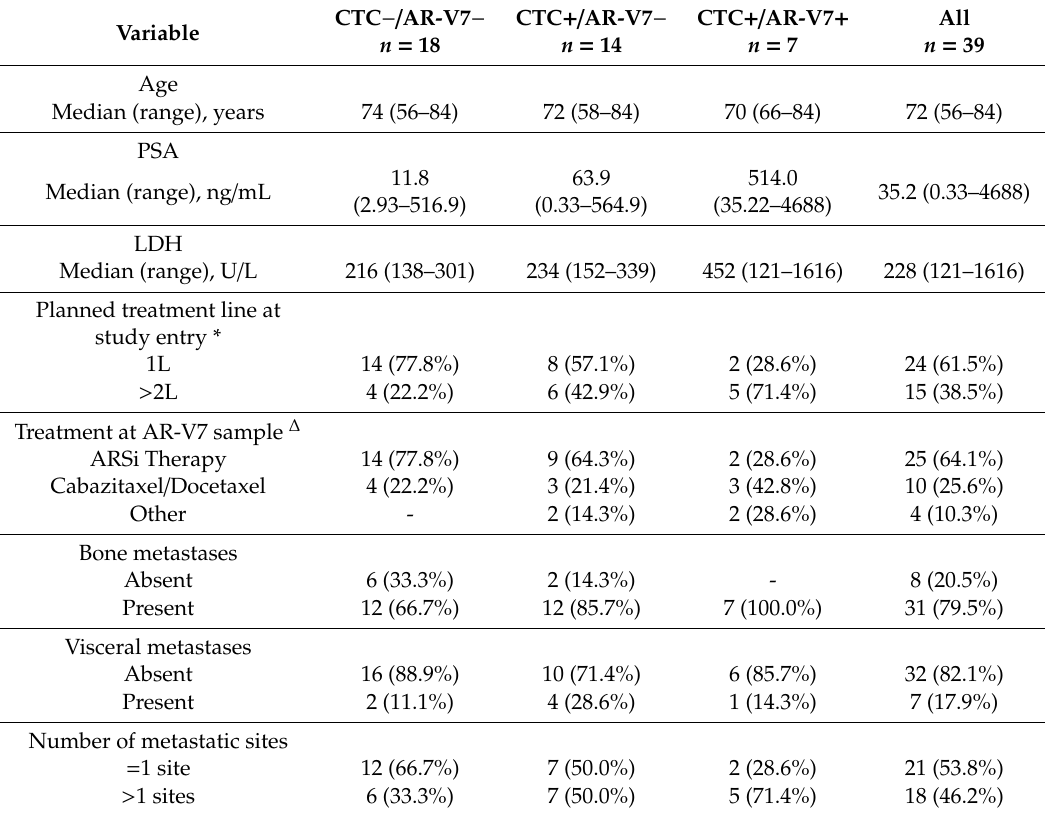
Table 1. Patient